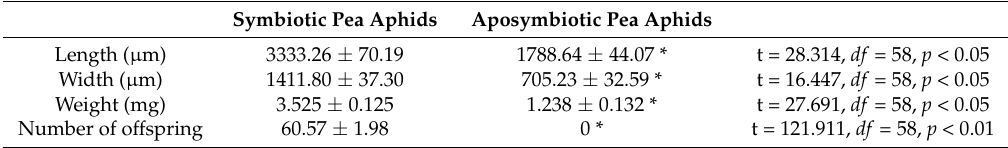
Table 1. The effects of Buchnera disruption on the body mass and fecundity of the pea aphid. Symbiotic Pea